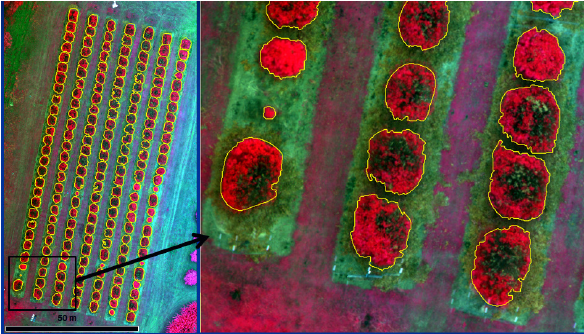
Figure 4. Results of the lychee tree crown delineation (yellow outlines) produced using object-based image